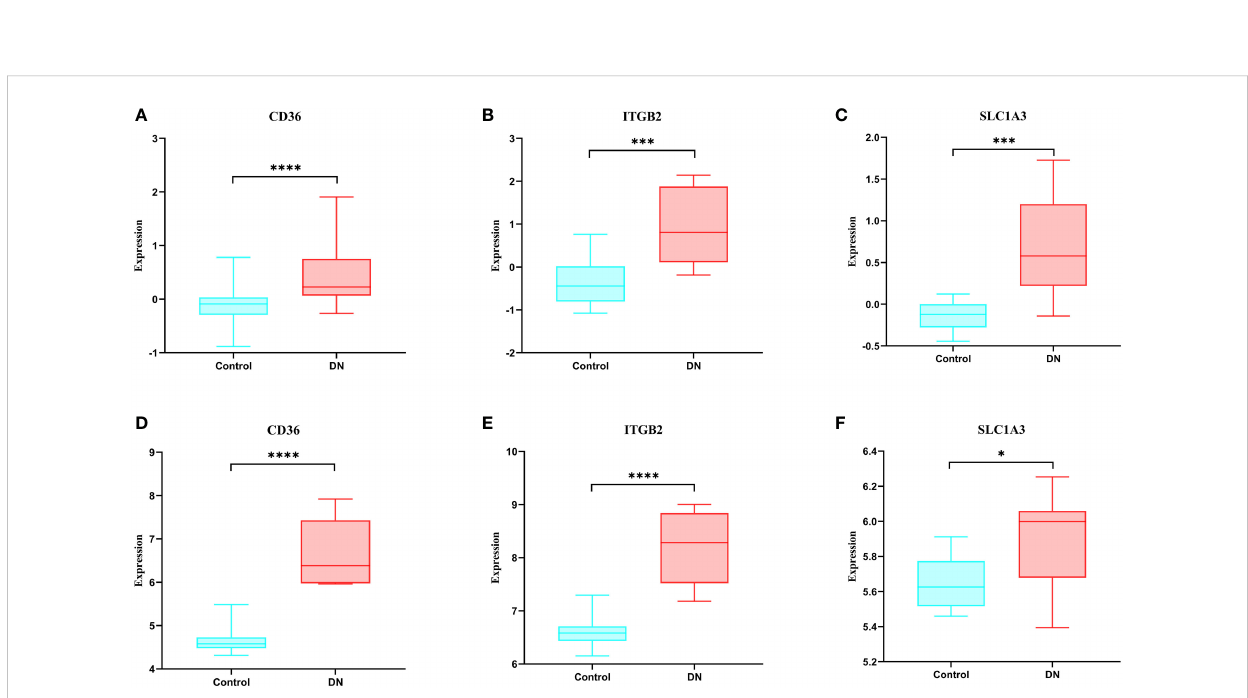
FIGURE 7 Expression of hub genes and validation of external datasets. (A-C) Expression of hub genes in the GSE30528 dataset. (D-F) Expression of hub genes in the GSE104948 dataset. * p<0.05; ** p<0.01; *** p<0.001; ****